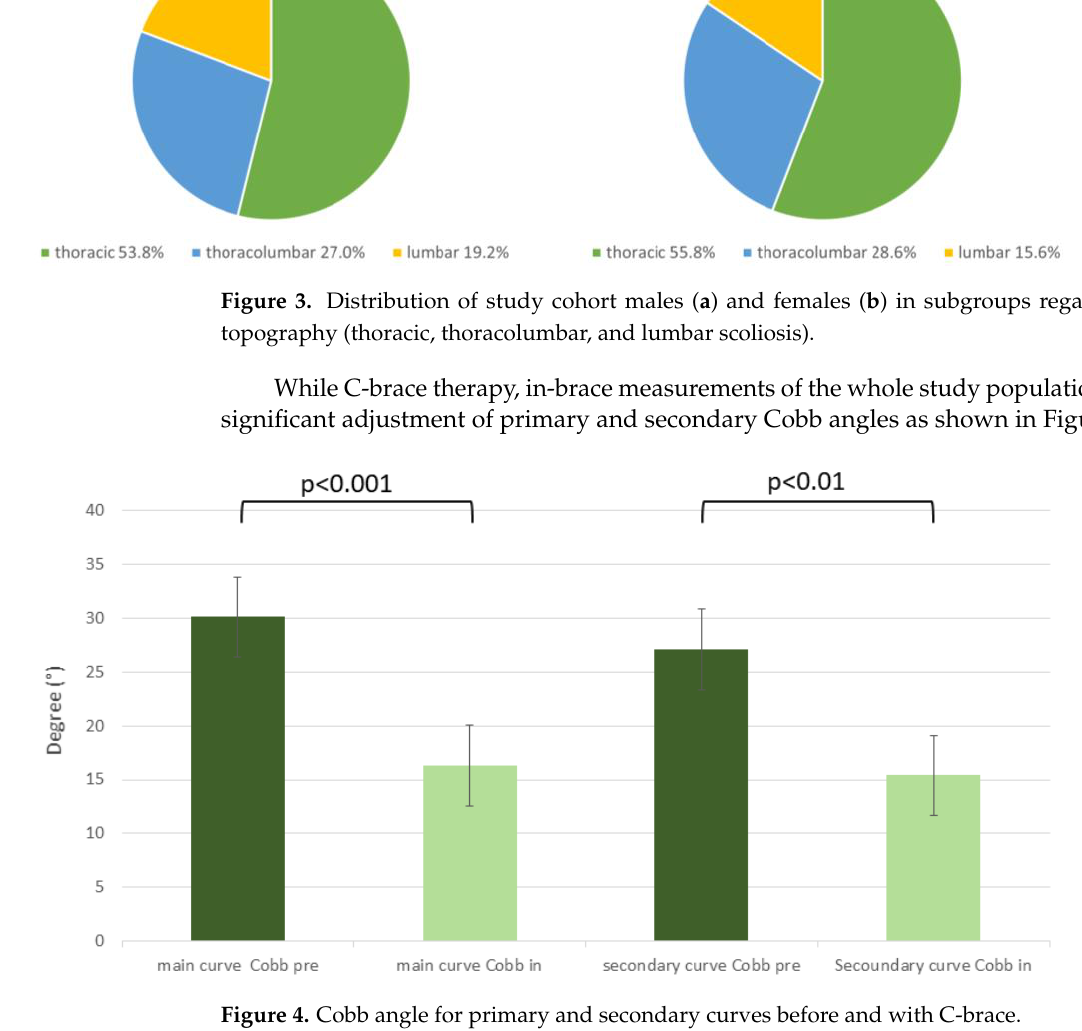
Figure 4. Cobb angle for primary and secondary curves before and with C-brace. Comparison of coronal and sagittal parameters of the whole study population (re-